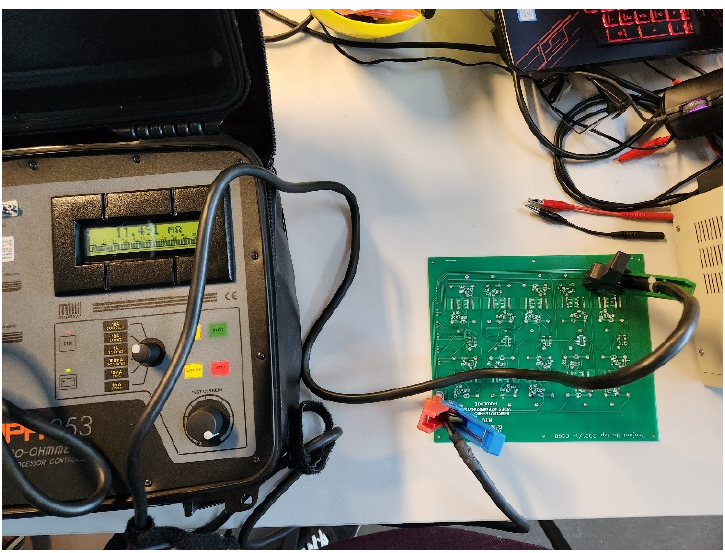
Figure 40. Setup for measuring SC circuit board trace resistance using a micro-ohmmeter.